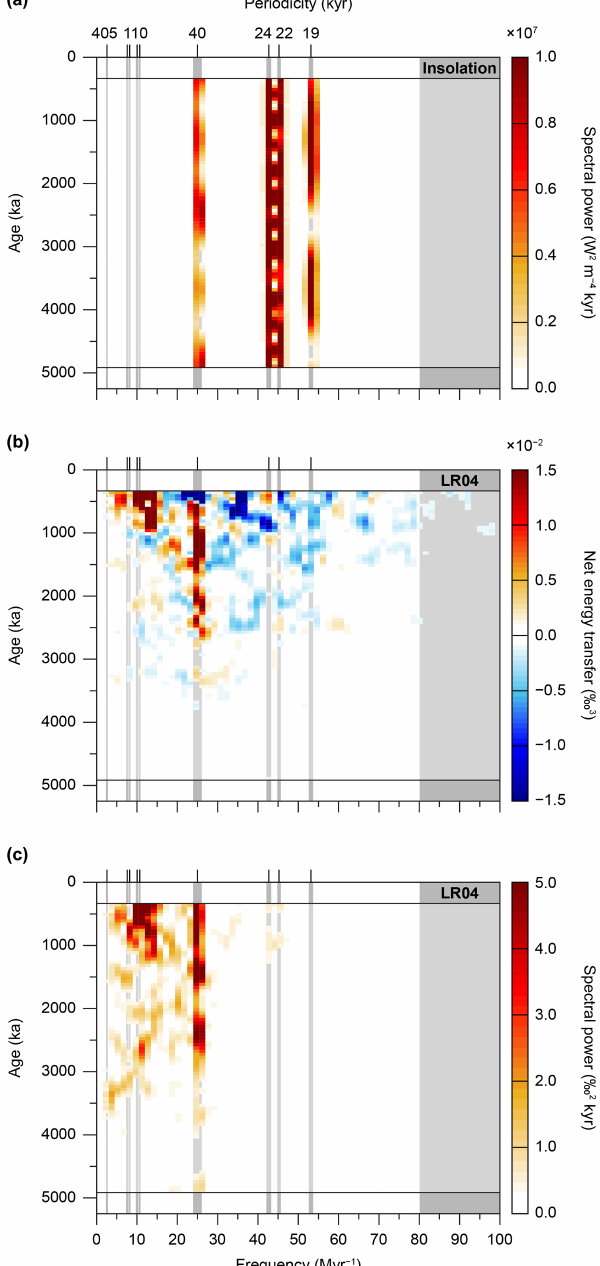
Figure 5. (a) Input → (b) “black box” climate → (c) output. (a) Power spectral density of mean summer insolation (21 June to 21 September) at 65 ◦ N (Paillard et al., 1996; Laskar et al., 2004). (b) Conservative net energy transfers (i.e. after correction using the coupling coefficient) during the Pliocene and Pleistocene, computed by integrating over the entire imaginary part of the bispectrum (see methods section). Input data are the resampled LR04 stack (Lisiecki and Raymo, 2005a). (c) Power spectral density of the LR04 stack (Lisiecki and Raymo, 2005a). For all three panels, the window length is 668 data points (668kyr), and the step size between par- tially overlapping windows is 50 data points (50kyr). We used no blocks and did not merge frequencies. These settings yield a fre- quency resolution of 1.50Myr − 1 and 2 degrees of